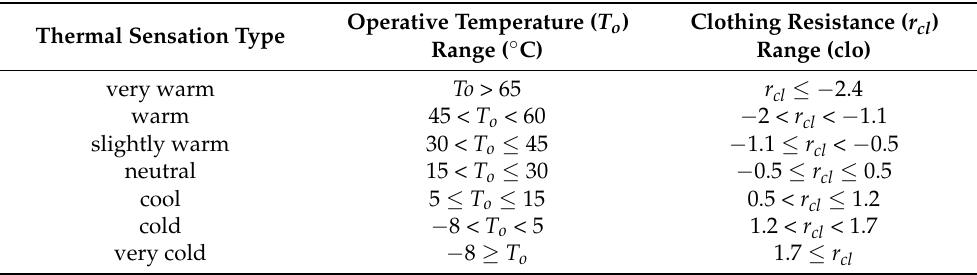
Table 3. Operative temperature and clothing resistance limits for different thermal sensation types obtained for 5 Hungarian persons.